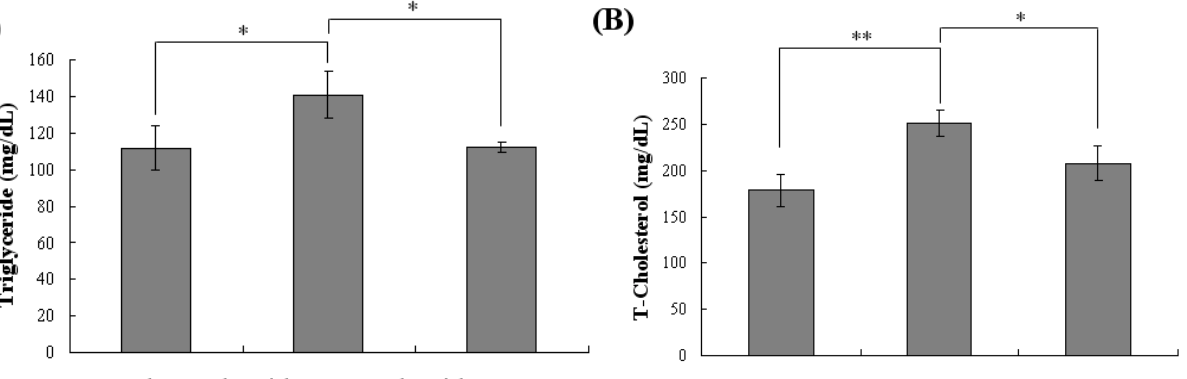
Figure 4. Effects of Buddleja officinalis Maximowicz treated on body weight in C57BL/6 fed high-fat diet ( A ) Triglyceride. Values are means ± SE (n = 9 per group) * p < 0.05 vs. normal diet; * p < 0.05 high fat-extract vs . high fat diet ( B ) T-Cholesterol. Values are means ± SE (n = 9 per group) ** p < 0.001 vs . normal diet; * p < 0.05 high fat-extract vs. high fat